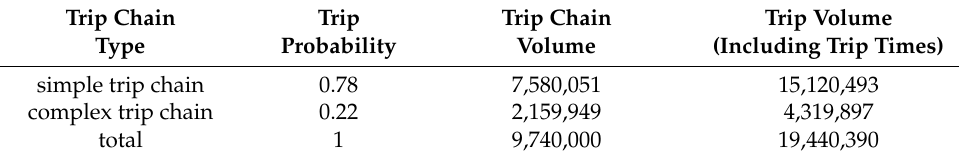
Table 4. The trip volume of different trip chain types.